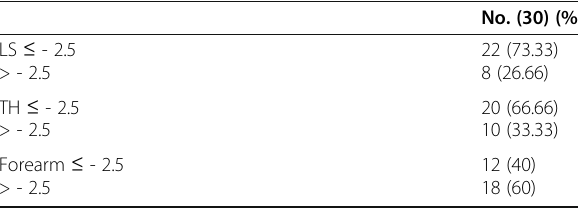
Table 2 DEXA score in positive anti-CarP patients: It showed increase percentage of patients who have osteoporosis in